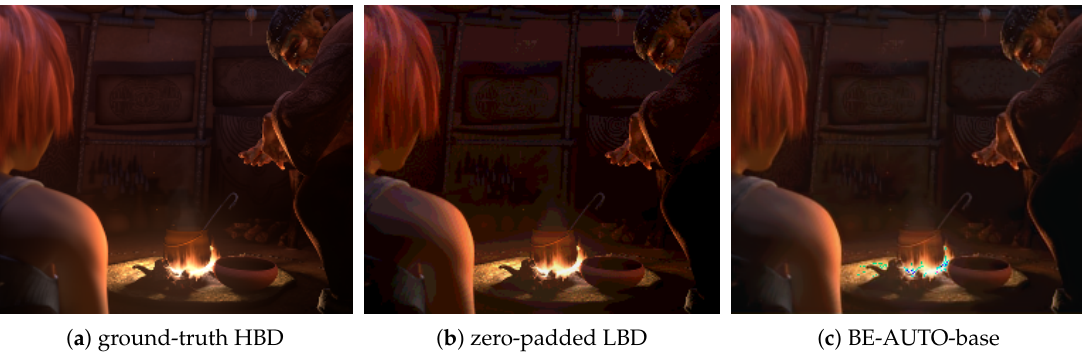
Figure 8. False contour suppression and color distortion [37]. ( a ) is the ground-truth 16-bit image; ( b ) is the zero-padded fake 16-bit image from 4-bit; and ( c ) is the result of